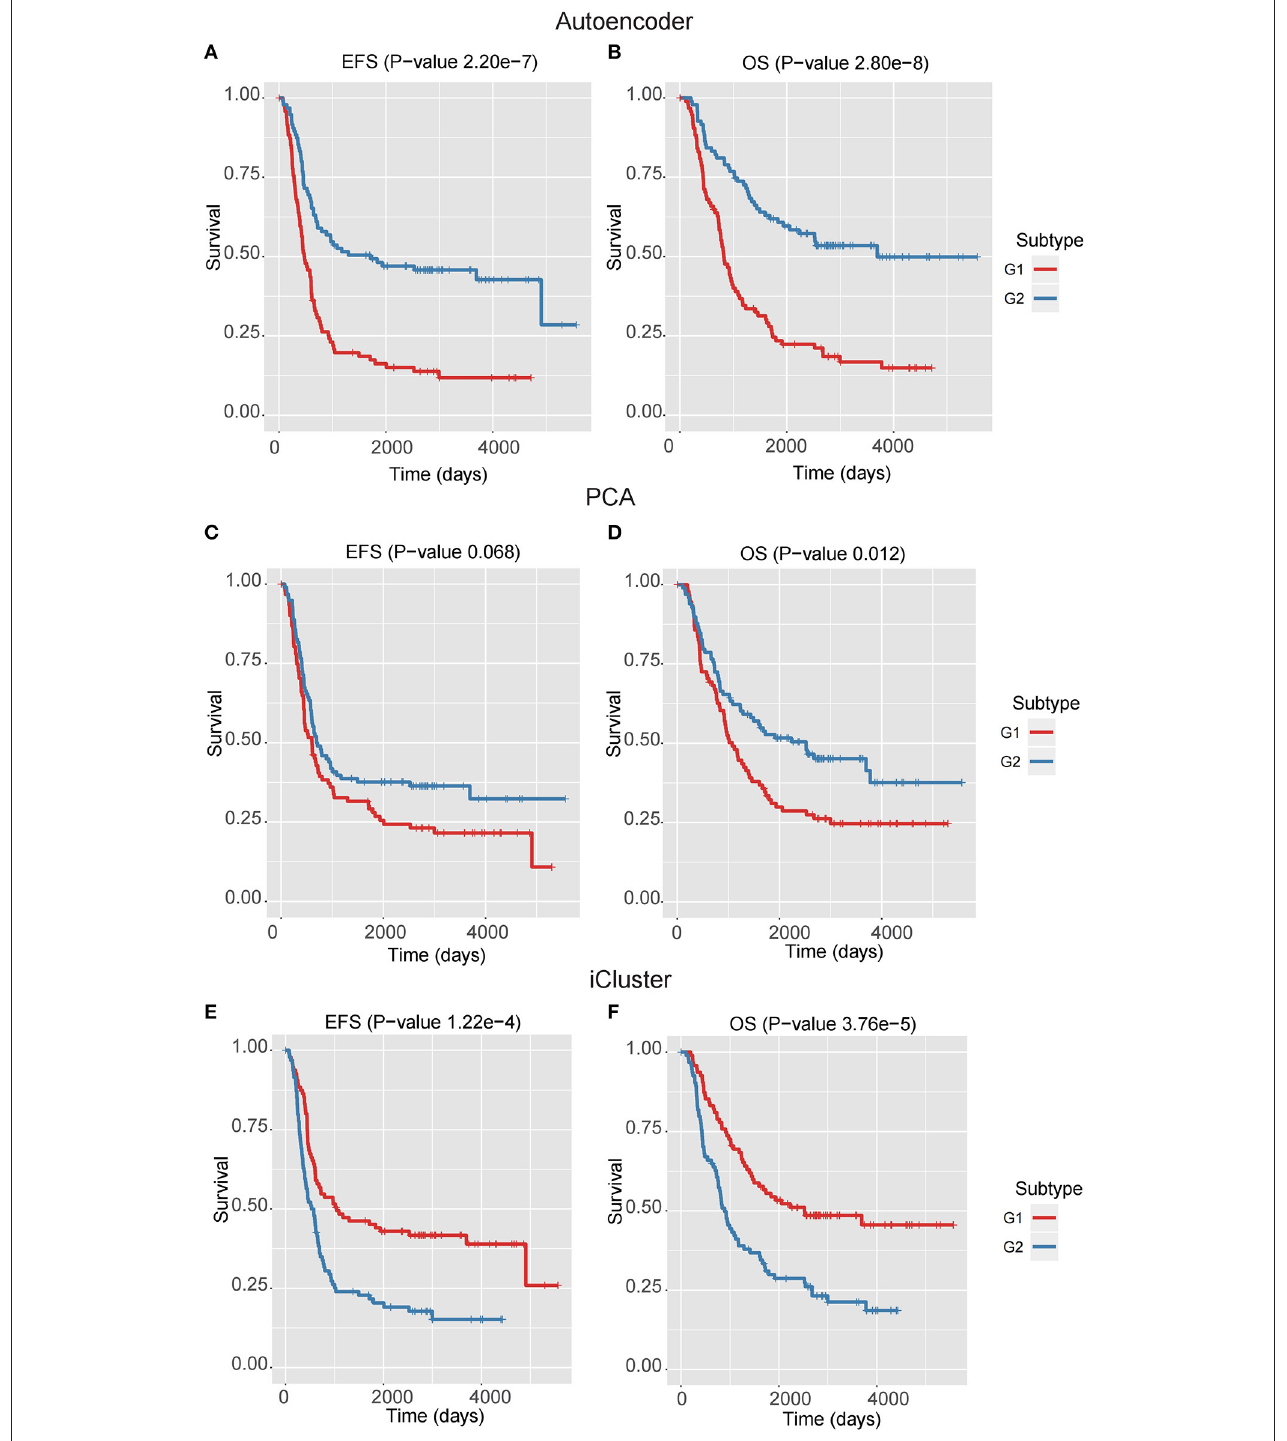
FIGURE 2 | The Kaplan–Meier curves for EFS or OS of two identified subtypes by three multi-omics integration algorithms, Autoencoder (A,B) , PCA (C,D) , and iCluster (E,F) .